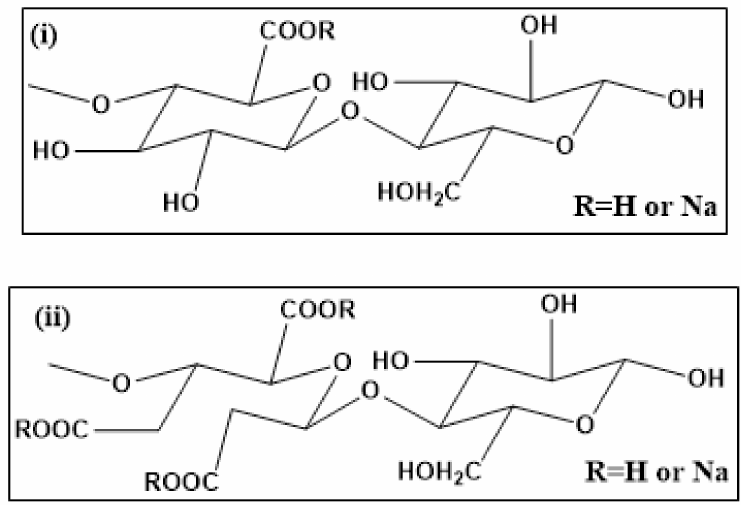
Figure 1. Structure of ( i ) 6CC, ( ii ) TCC.